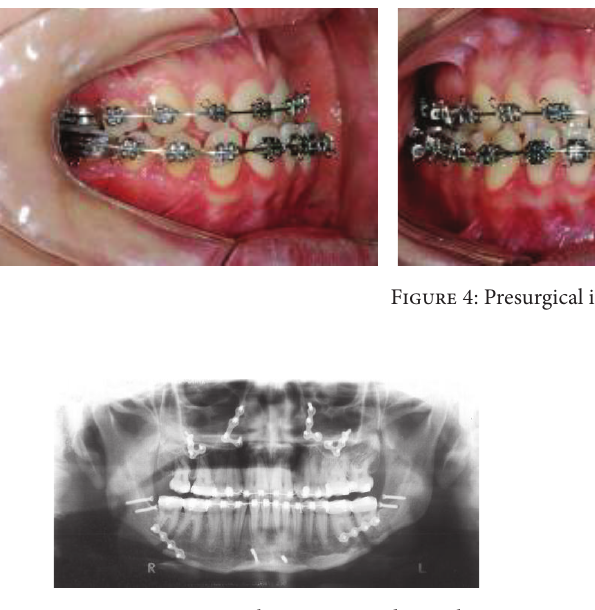
Figure 5: Postsurgical panoramic radiograph.